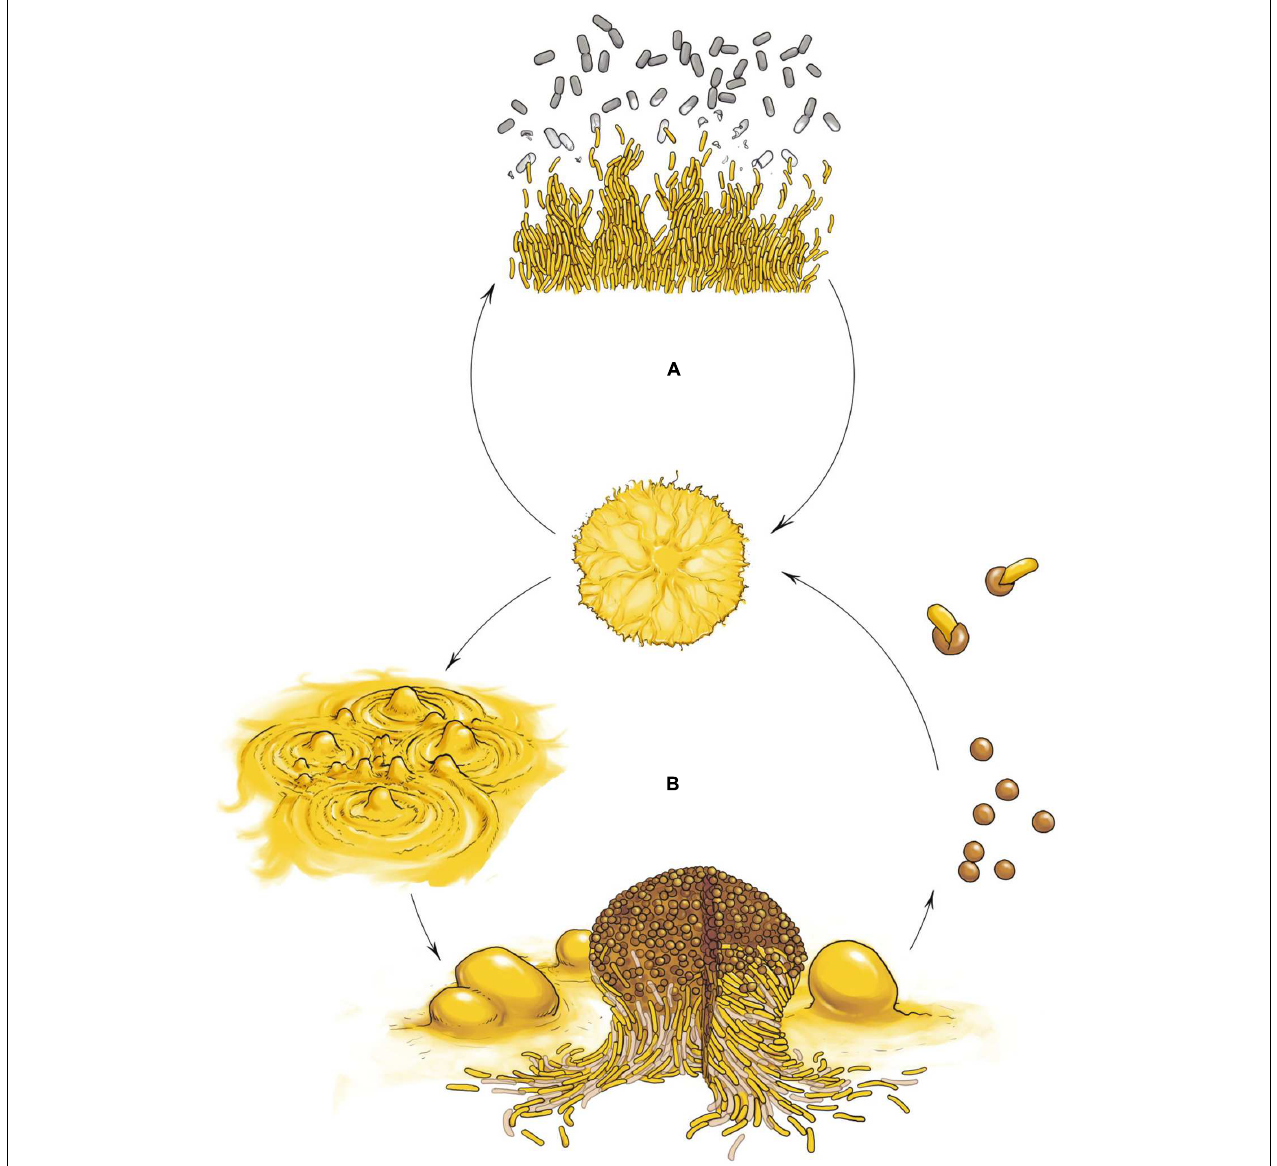
FIGURE 1 | Myxococcus xanthus multicellular cell cycle. (A) Vegetative growth. In the presence of nutrients cells move in a coordinated manner, forming swarms. When swarms make contact with the prey, cells penetrates the prey colony and lyse the cells. (B) Developmental cycle. Upon starvation, cells moving collectively initiate a developmental program and exchange extracellular signals as well as physical contact signals to first form aggregates and later build millimeter-long upright fruiting bodies filled with differentiated, reproductive and environmentally resistant cells called myxospores (rounds cells), surrounded by two other subpopulations showing division of labor: a monolayer of aligned non-reproductive peripheral rods (yellow rod cells) and cells that undergo altruistic obligatory autolysis by programmed cell death (light brown rod cells). Myxospores ensure survival during starvation or desiccation and can be dispersed to other environments and germinate when nutrient conditions